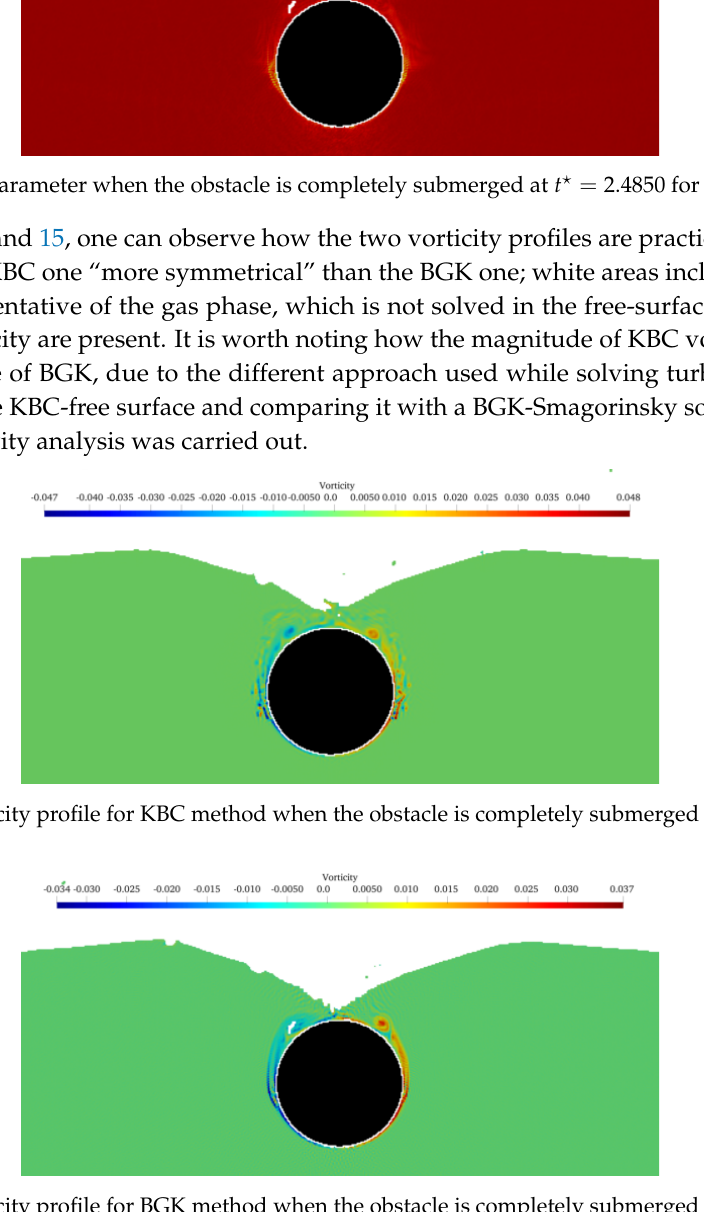
Figure 15. Vorticity profile for BGK method when the obstacle is completely submerged at t (cid:63) = 2.4850 for Fr =